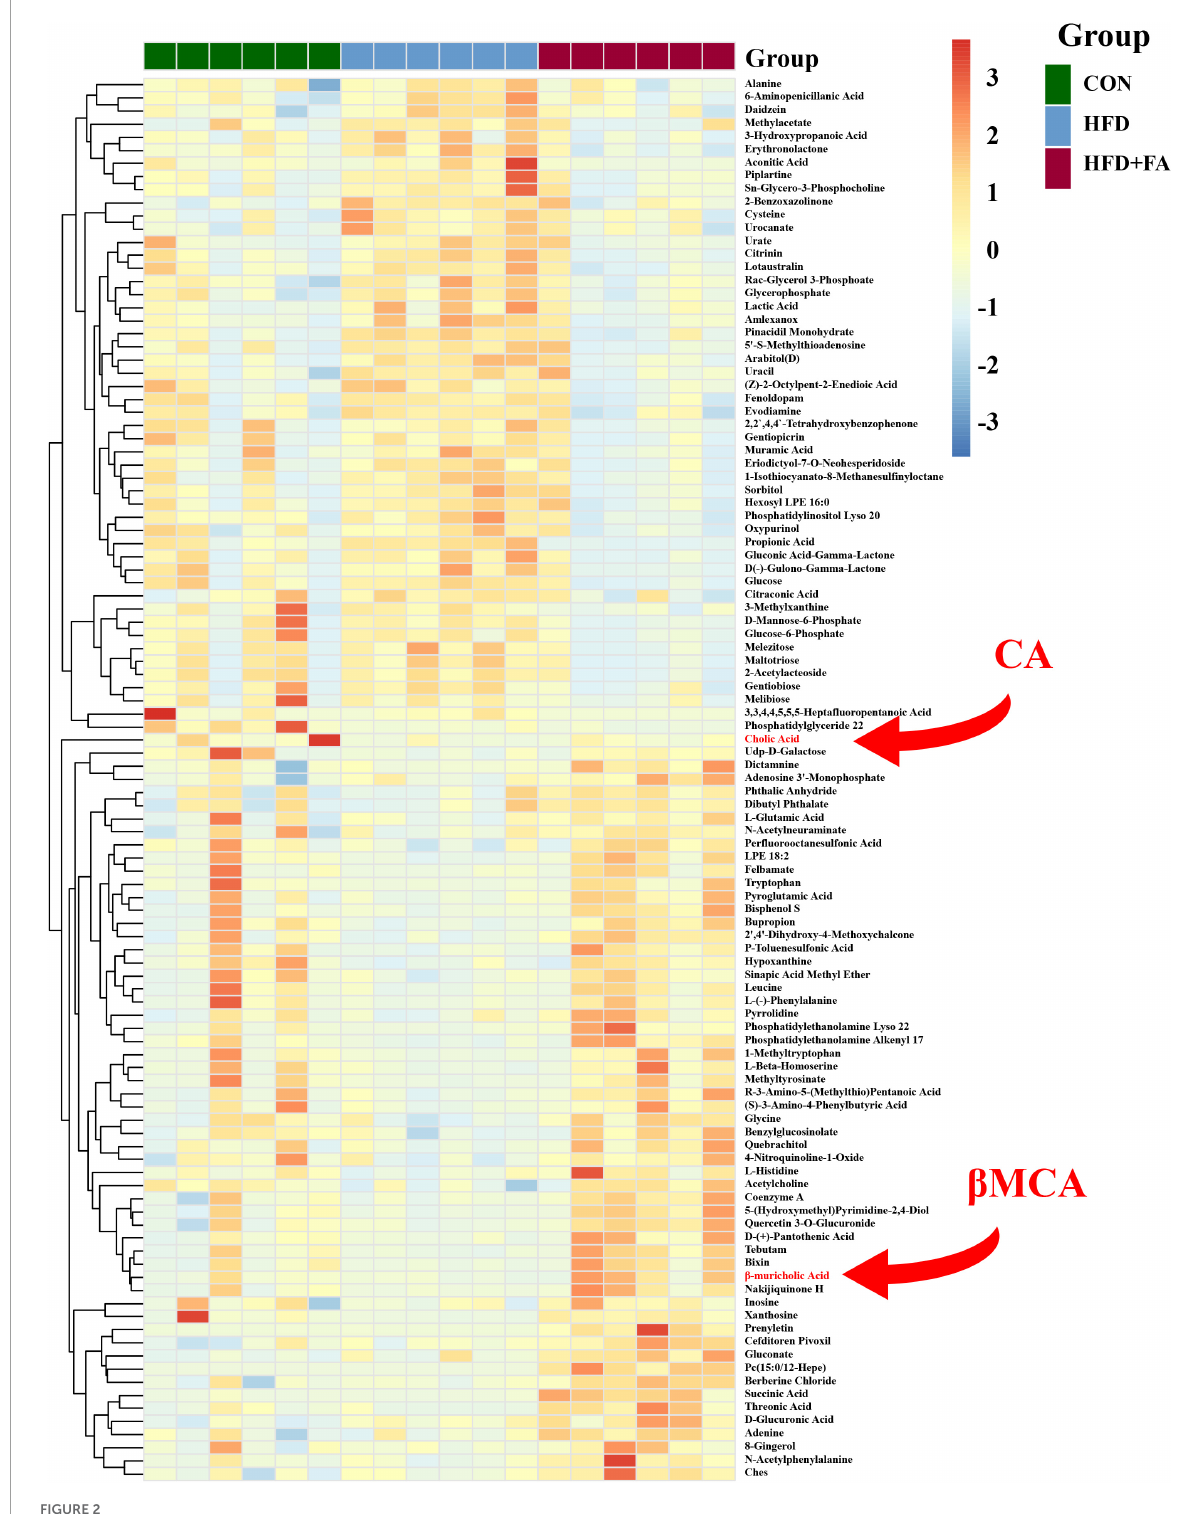
FIGURE2 Effects of FA supplementation on hepatic metabolite profile in HFD-fed mice. The hepatic metabolomics analysis was performed in the CON, HFD and HFD + FA mice. Heatmap of representative differential metabolites from the CON, HFD and HFD + FA mice ( n = 6). Colors represent the contents of differential metabolites with red indicating a high content and blue indicating a low content. The red arrow indicates metabolites CA and β MCA. CON, control diet group; HFD, high-fat diet group; HFD + FA, high-fat diet with 100 mg/kg bw/day FA